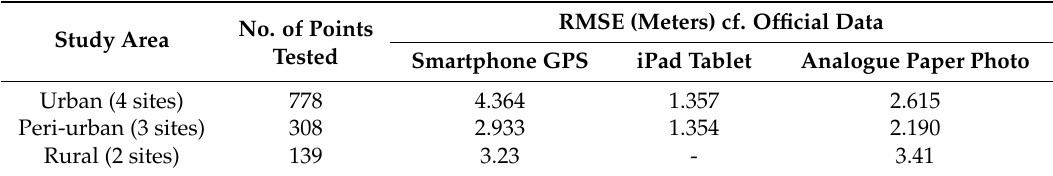
Table 2. Root mean square error (RMSE) for parcel corners for compared datasets aggregated by locality. Study